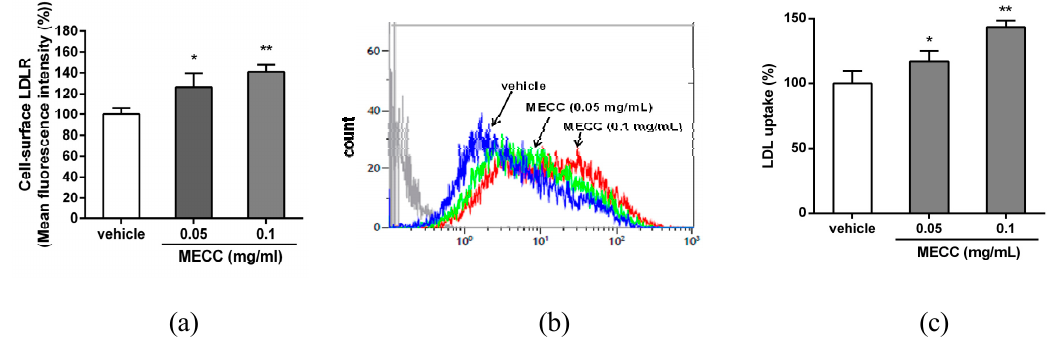
Figure 3. Effects of MECC on the level of cell-surface LDLR and LDL uptake activity in HepG2 cells. HepG2 cells were cultured in LPDS medium and treated with vehicle (0.1% DMSO) or MECC (0.05 and 0.1 mg/mL) for 24 h. ( a ) The amount of cell-surface LDLR was measured by flow cytometry analysis. ( b ) The cells were incubated with BODIPY ® -FL-LDL for 24 h, and the LDL uptake was determined using flow cytometry analysis. The experiments were replicated three times, and a representative histogram was shown. ( c ) Summary of LDL uptake. The data are presented as the means ± SD from three independent experiments. * p < 0.05 and ** p < 0.01 represent significant differences compared to the vehicle-treated group.